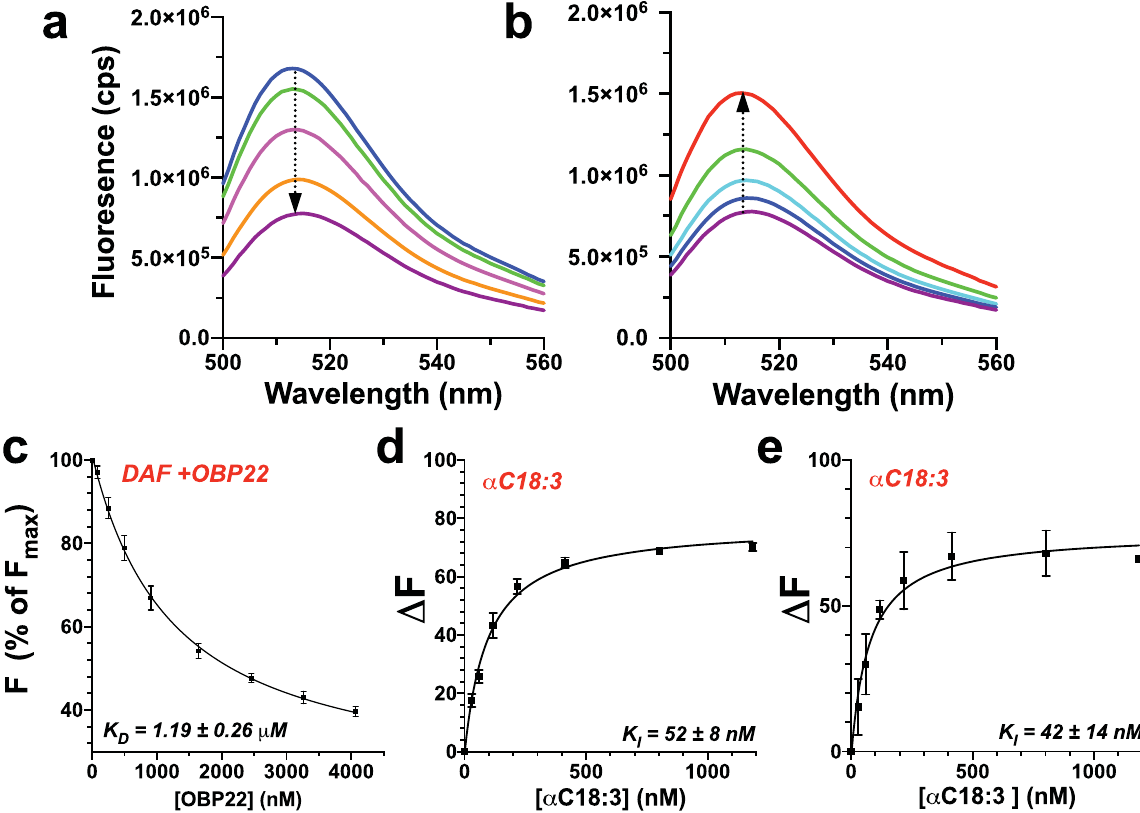
Figure 6. Long chain fatty acids bind with high affinity to AeOBP22. (a) Florescence emission spectra of DAF (blue) excited at 490 nm, with increasing amounts of AeOBP22 (arrow) shows concentration dependent quenching. (b) Titration of the final sample in a, with increasing linoleic acid (arrow) shows that the fatty acid competes for binding of DAF and recovery of initial fluorescence (red). (c) Determination of binding constant for AeOBP22 and DAF from 7 replicates of experiments shown in panel (a). DAF concentration was 84 nM. Plot of the intensity at the florescence maximum (513 nm) presented as change from initial fluorescence. Data were fit according to Eq. 2. (d) Determination of the binding constant of α -linoleic acid at pH 8.0 from multiple replicates (n = 3) of experiments shown in panel (b) by fit of the raw intensity using Eqs. 2 and 3 using a K D for DAF of 1.191 μ M. The DAF concentration was fixed at 100 nM and the protein at 1000 nM. Data are presented as normalized recovery of the quenched fluorescence for ease of viewing. (e) The same experiment as in (d) but recorded at pH 5 (n = 2). Intrinsic DAF fluorescence is significantly quenched at pH 5.0 leading to increased error in measured points.